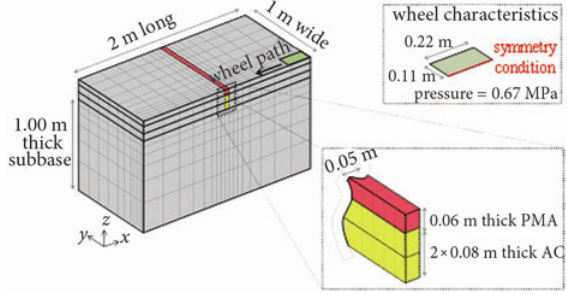
fig. 5. 3D FE specimen geometry (mirror symmetry in the ( x , z ) plan) and a mesh used in the pavement response